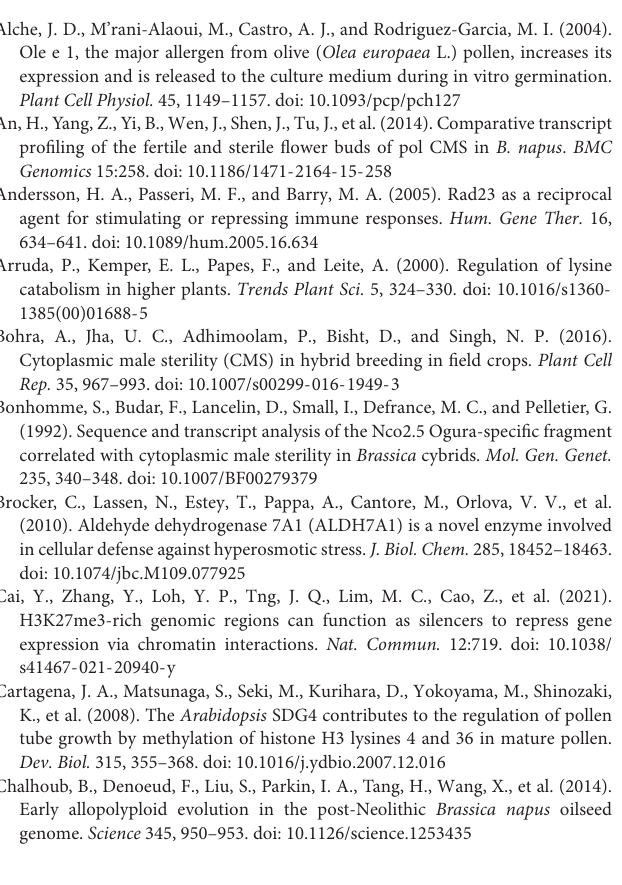
( rfw1 , rfw2 , and rfw3 ). Supplementary Figure 7 | Heatmap of DEGs. (A) YABBY , PEM , APs , and SWEET family differentially expressed genes (between fertile and sterile buds) that were enriched in the top ten GO terms. BP, biological process; CC, cellular component; MF, molecular function. (B) Plant hormone-related genes that were